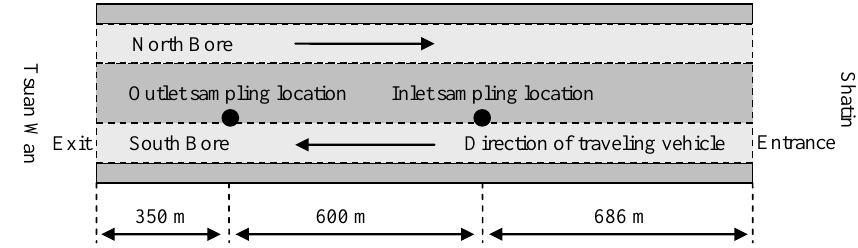
Fig. 1. Schematic diagram of the Shing Mun Figure 1.